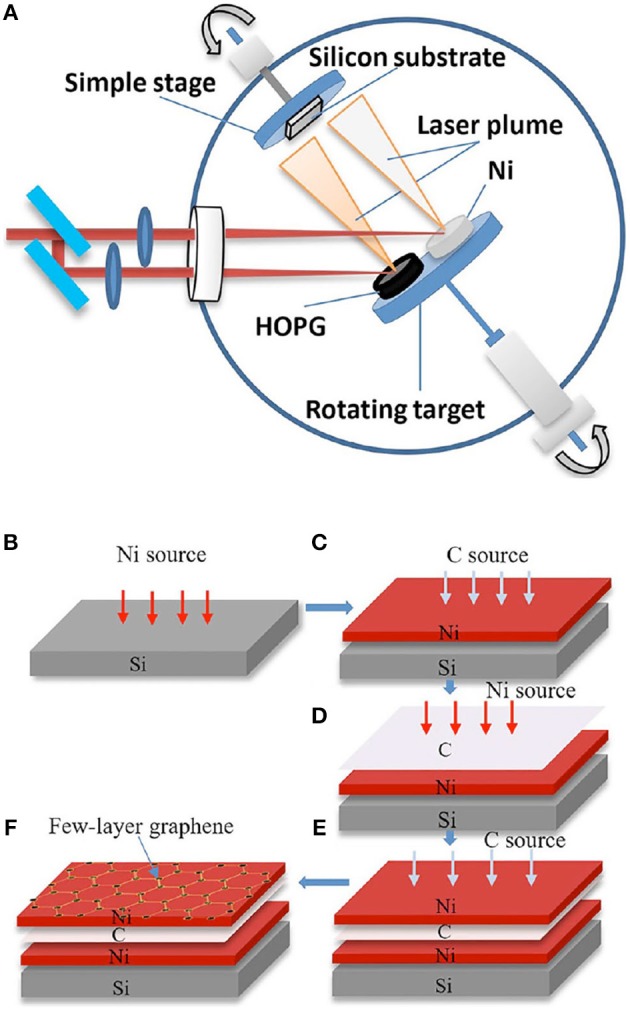
(A) Schematic image of the laser deposition system; steps (B–F) are used in few-layer graphene deposition [Reproduced from Dong et al. (2017) with permission of Springer].